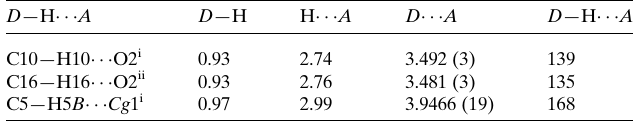
Table 3 Hydrogen-bond geometry (A˚ , (cid:3) ) for (I). Cg 1 is the centroid of the C25–C29/C34 ring.